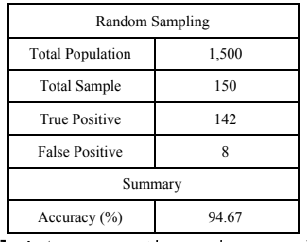
Table 4. Assessment by random sampling.